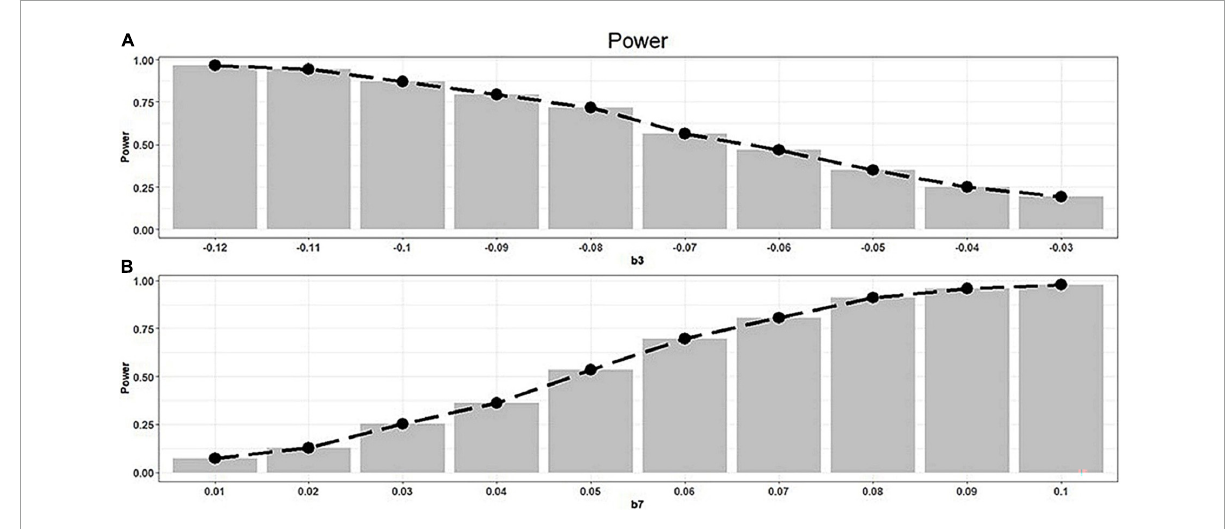
FIGURE2 The average power for moderated moderation model. (A) Average power for testing whether b 3 = 0. (B) Average power for testing whether b 7 =